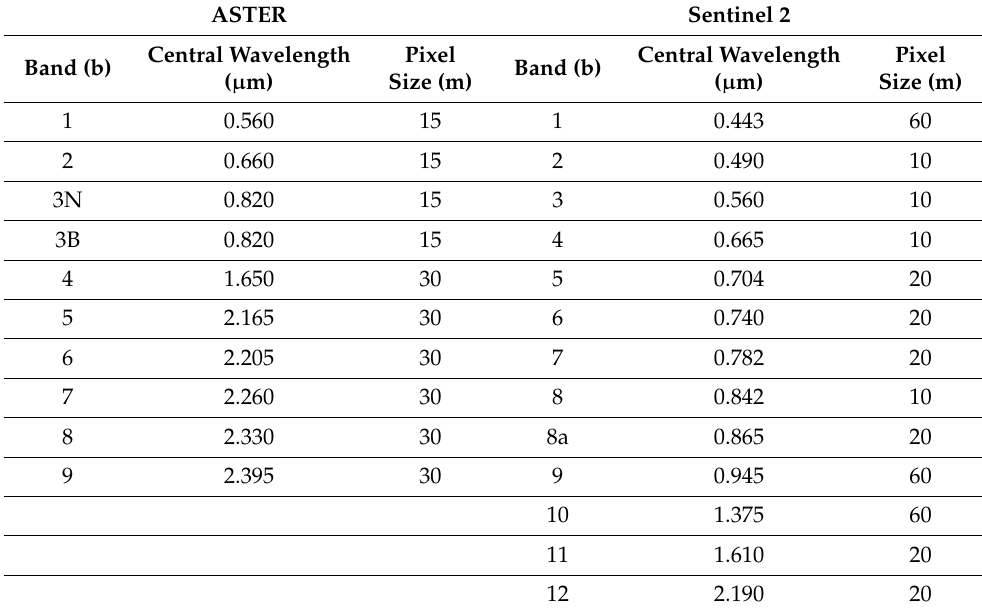
Table 1. Characteristics of the ASTER and Sentinel